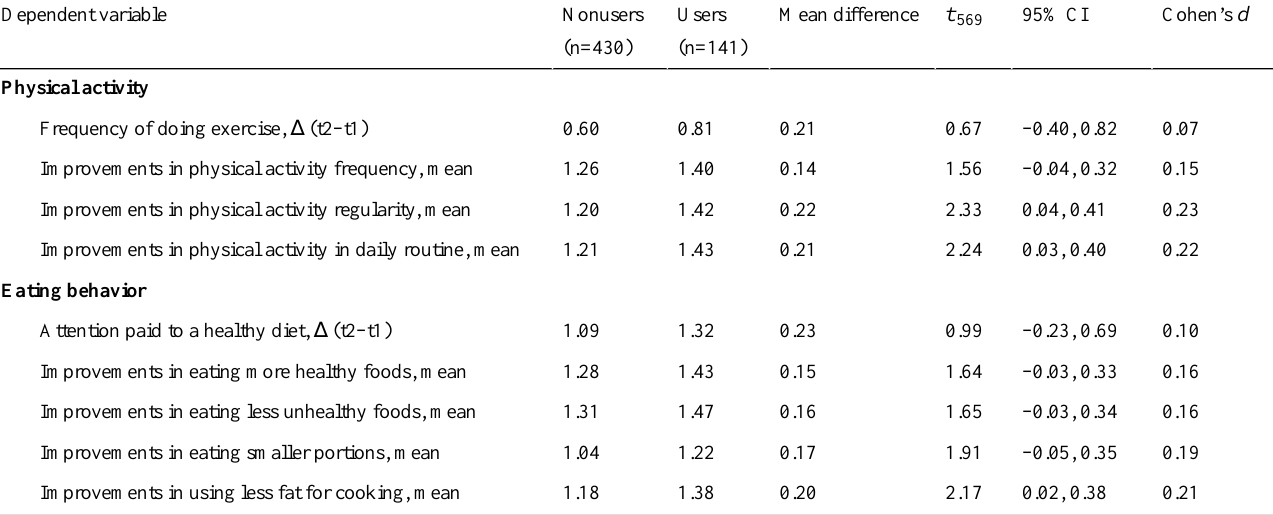
Table 5. Independent t tests—as-treated